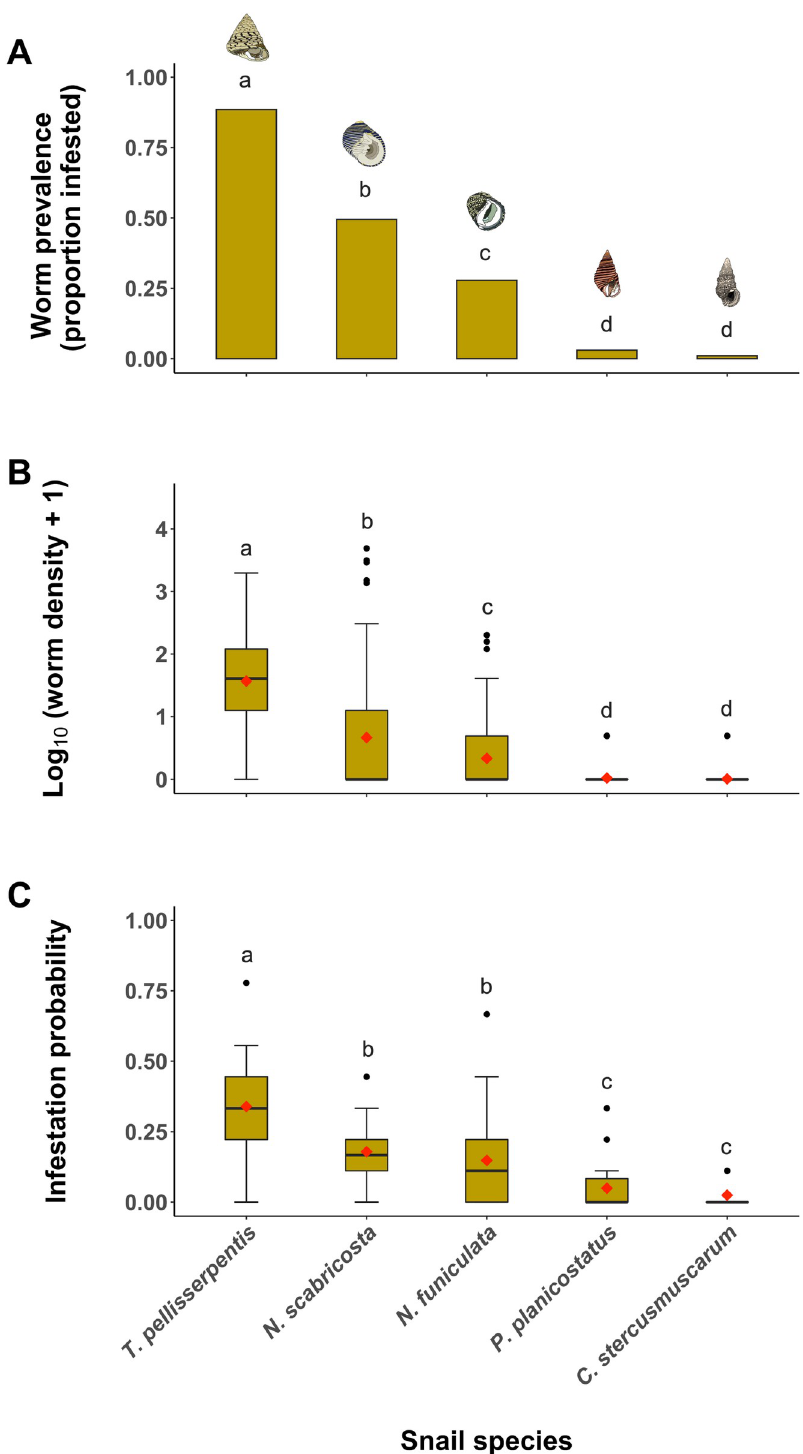
Fig 2. Prevalence and density of flatworm infestation in the field and flatworms’ host choice in the laboratory. (A) Proportion of snail individuals infested by flatworms in the field, (B) box plot of flatworm infestation density (no. worm per snail) in the field, and (C) box plot of infestation probability (i.e., a proportion of individual worms selecting a particular host species) measured during the host selection experiment. In box plots, mean values for different snail groups are represented by red diamond symbols. Different letters indicate a significant difference based on post hoc multiple comparisons (Holms-corrected P < 0.05). https://doi.org/10.1371/journal.pone.0247551.g002 PLOS ONE | https://doi.org/10.1371/journal.pone.0247551 March 2,